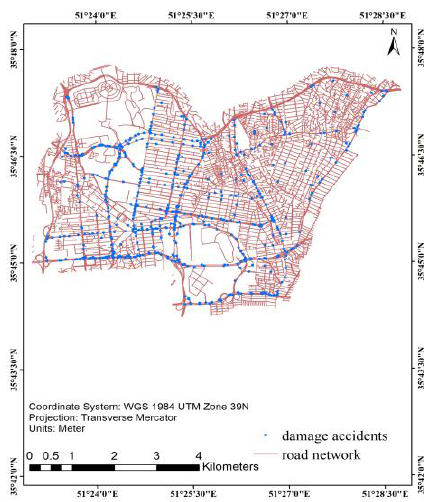
Figure 1. damage Car accidents damage location in Tehran District 3 during 2013-2017